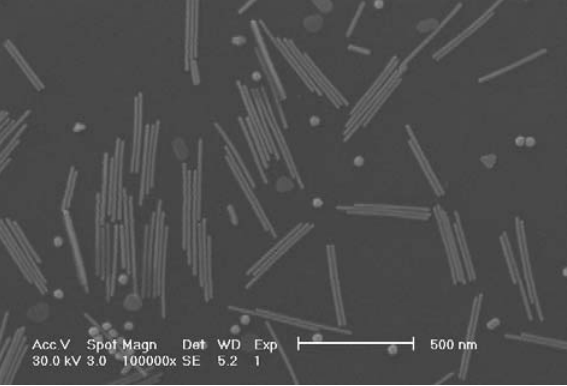
Fig. 2 SEM image of gold nanorods prepared in the presence of 0.1 M CTAB. intensity.